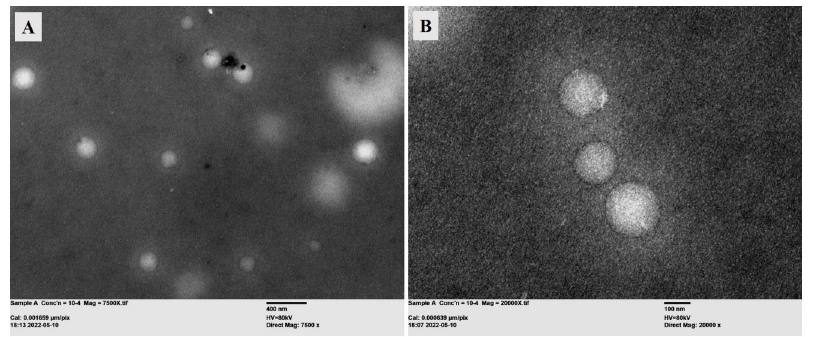
Fig 1. TEM analysis of 5-FU-loaded SLNs at (A) 7500X magnification (scale bar 400 nm) and (B) 20000X magnification (scale bar 100 nm).